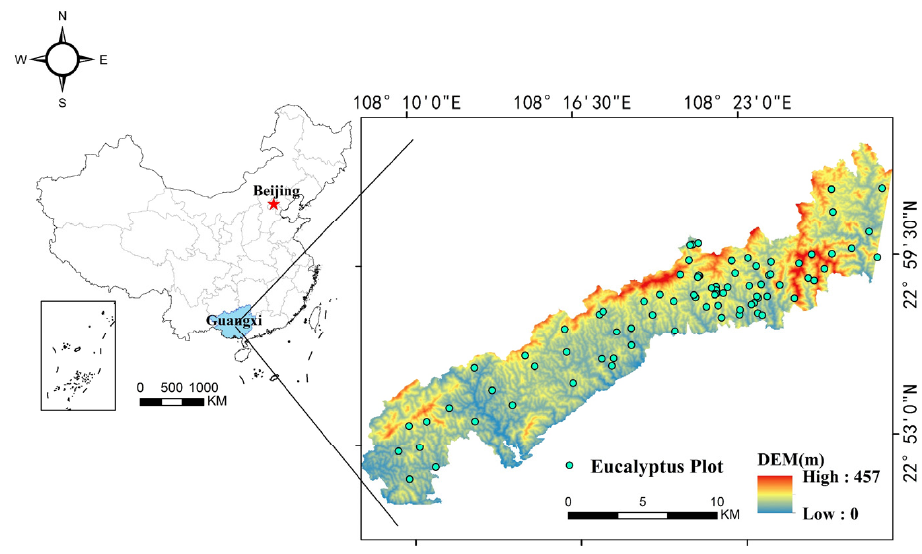
Figure 1. The location of the study area, and the distribution of the ground samples in planted eucalyptus forest.